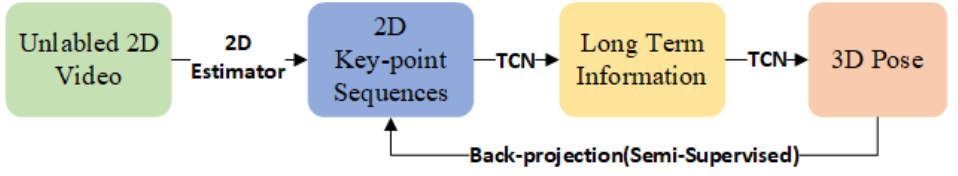
Figure 3. Illustration of Pavllo’s fully convolutional